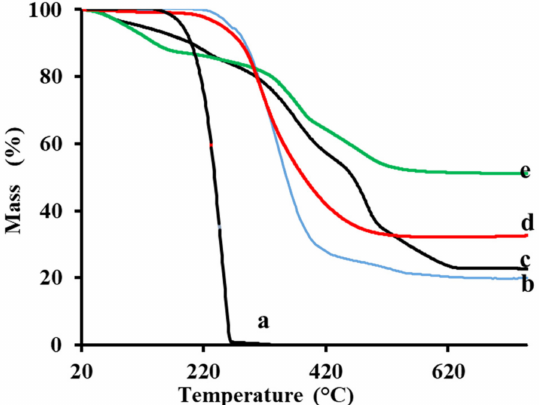
Figure 5. TG profiles of IBU ( a ), BL ( b ), LDH-IBU ( c ), LDH-BLE ( d ), and Mg / Al-NO 3 LDH ( e